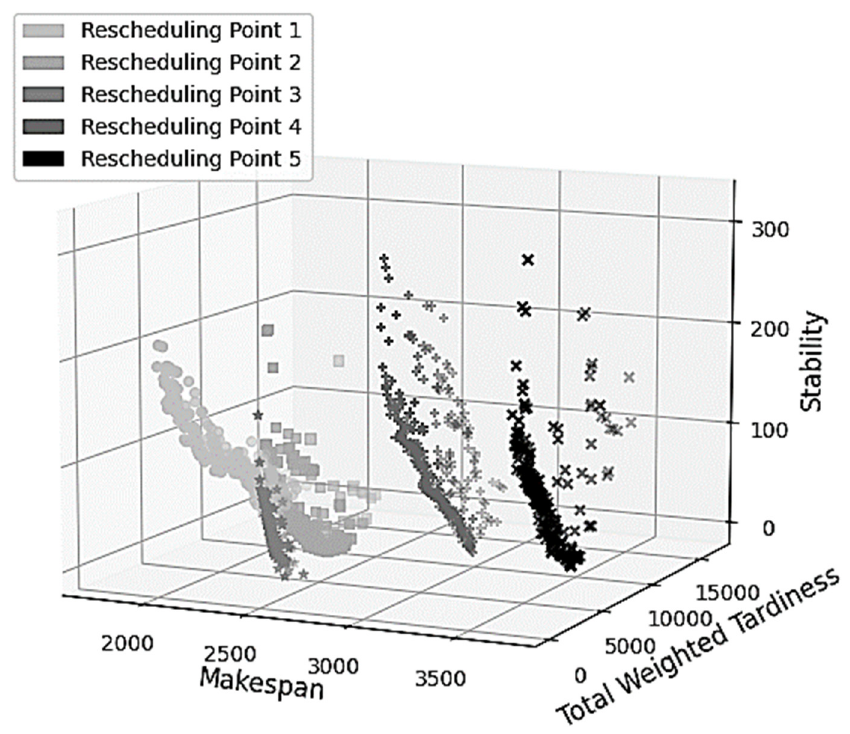
Figure 6. Dynamic Pareto evolution for HDNSGA-II in TA_20_10_3.